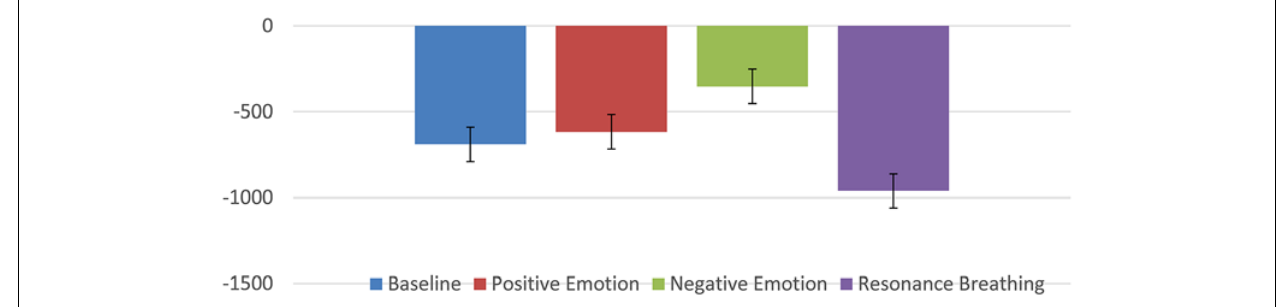
FIGURE 2 | N250 (in microvolts) evoked potential during various